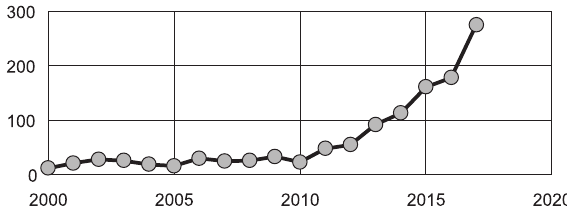
Fig. 1. An increase in citations of articles published in Quaestiones Geographicae in the 21st century according to Scopus, a scientific data base, carried out by the publishing company Elsevier (the state as at 1 March